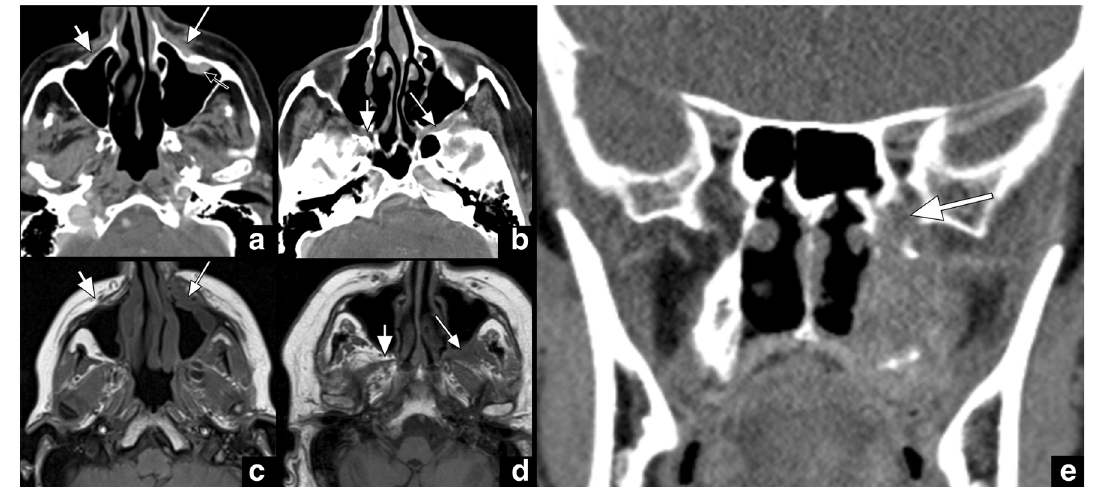
Fig. 3 Axial CT ( a and b ) and axial T1-weighted ( c and d ) images show obliteration of the preantral fat pad on the left ( long white arrow in a and c ) when compared to its normal appearance on the right ( short white arrow in a and c ). In addition, note the enhancing soft tissue within the maxillary sinus ( black arrow in a ) as well as the obliteration of the fat pad in the left pterygopalatine fossa ( long white arrow in b and d ) compared